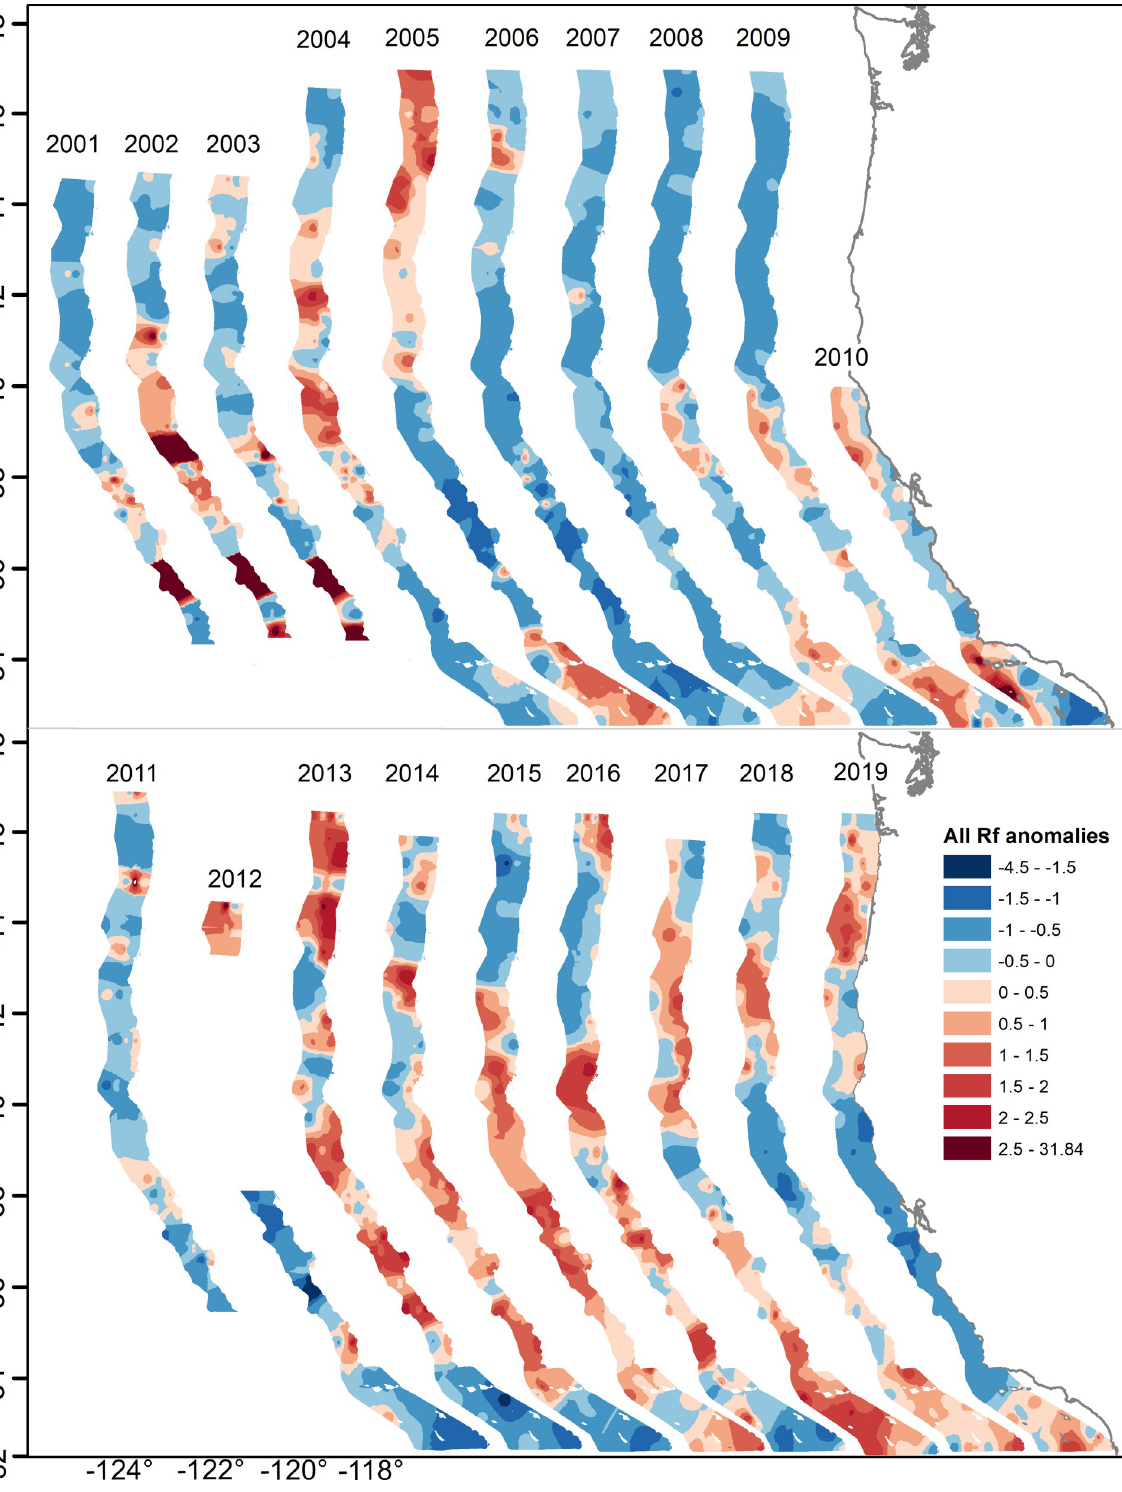
PLOS ONE | https://doi.org/10.1371/journal.pone.0251638 May 27,